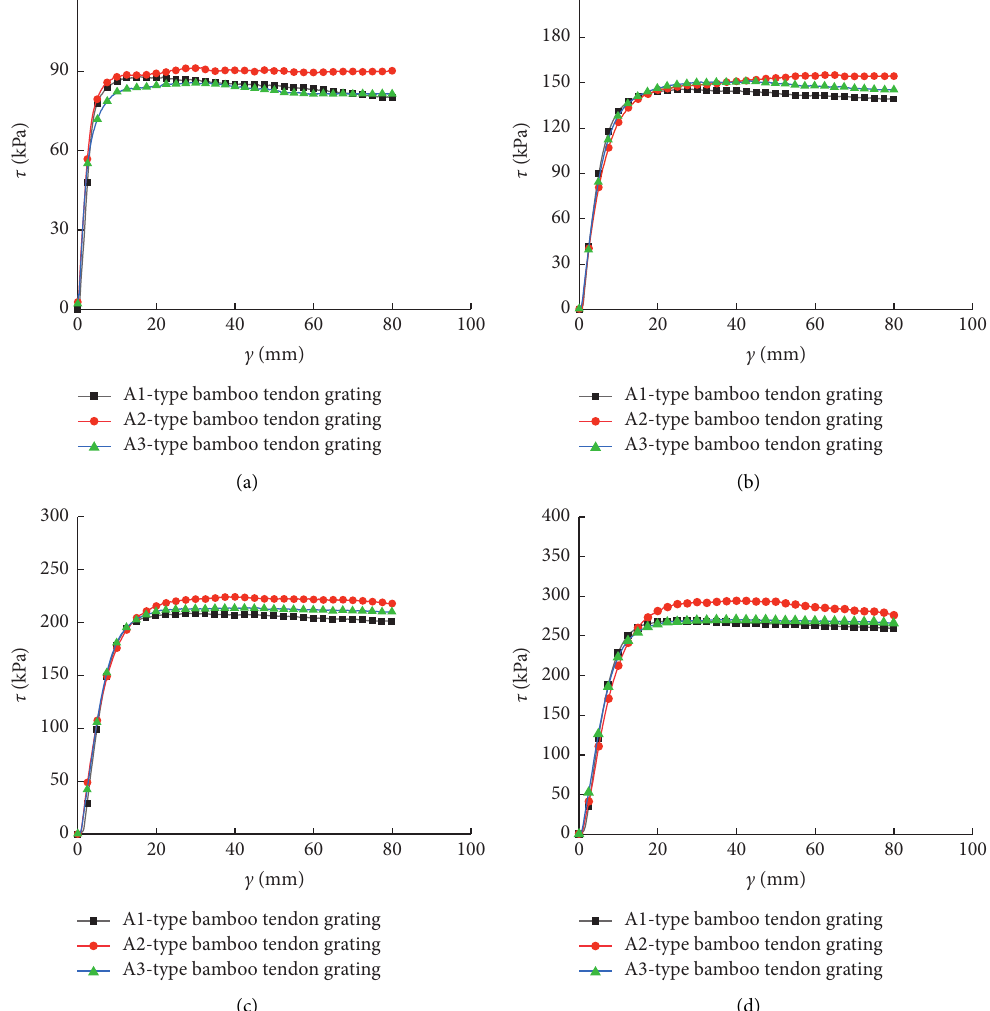
Figure 17: Shear stress-displacement curves of reinforced bamboo tendon grating with different spacings: (a) 100 kPa normal stress, (b) 200 kPa normal stress, (c) 300 kPa normal stress, and (d) 400 kPa normal